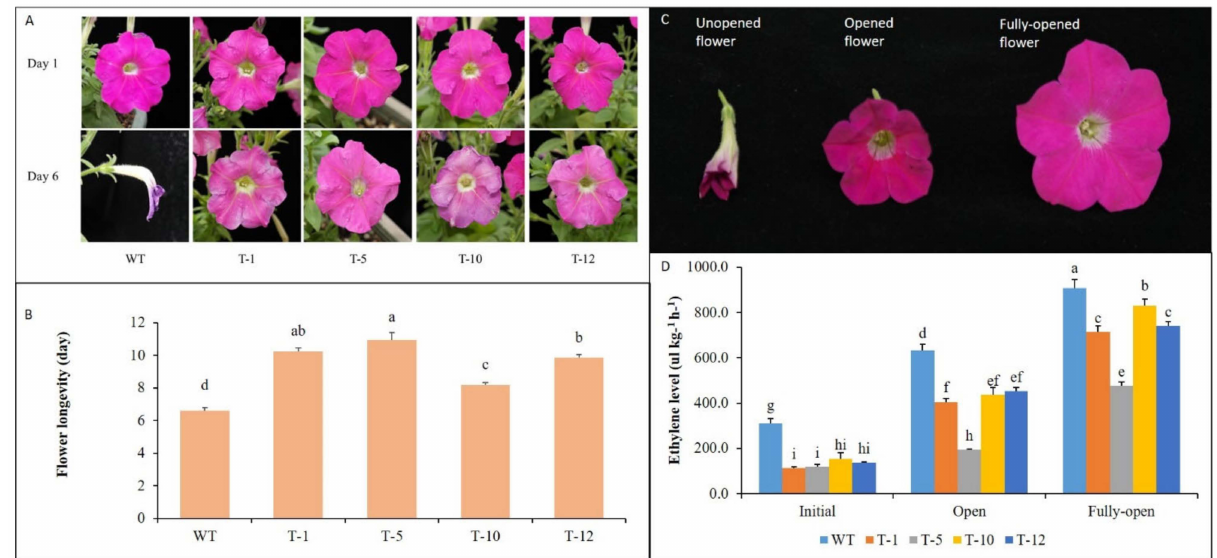
Figure 1. acdS overexpression improves flower longevity of petunia cv. ‘Mirage Rose’. Comparison of the status of flower senescence ( A ) and flower longevity ( B ) of wild-type (WT) and transgenic plants. Illustration of three different flower stages ( C ) and ethylene production in the stages ( D ) of WT and transgenic plants. Data represent the means of three replicates and error bars indicate standard error. Means with the same letters are not significantly different by least significant difference test (LSDT, p <